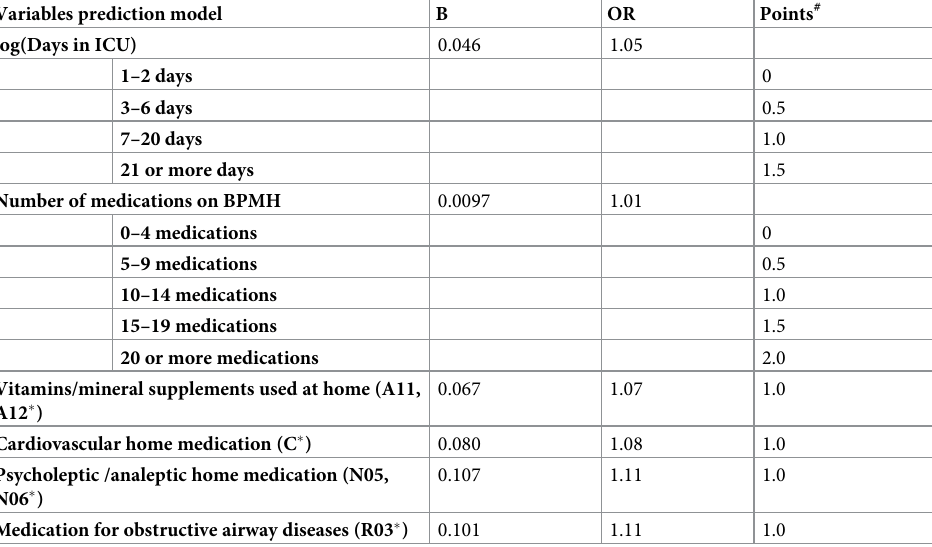
B = Regression coefficients, OR = Odds ratio, BPMH = Best possible medication history # = Points for the simplified prediction rule derived from the regression coefficient. � = Anatomical Therapeutic Chemical codes [24]: A11 = vitamins, A12 = mineral supplements, C = cardiovascular medication (digoxin, antihypertensives, diuretics, vasoprotectives, beta-blocking agents, calcium channel blocking agents, renin-angiotensin system blocking agents or lipid modifying agents), N05 = psycholeptic medication N06 = analeptic medication, R03 = Medication for obstructive airway